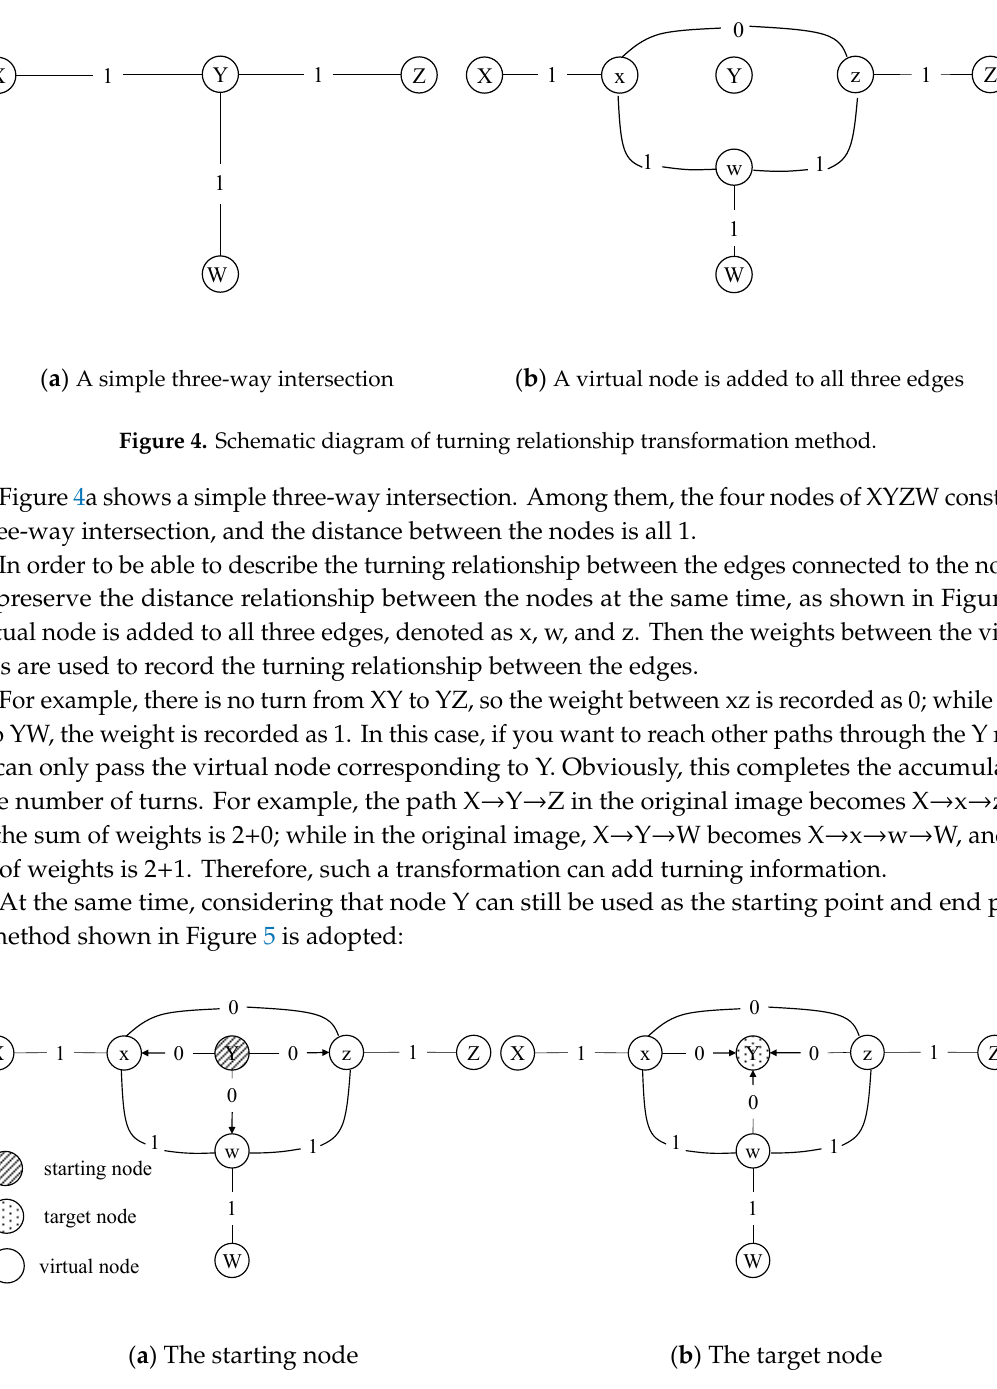
Figure 5. Starting node and target node.